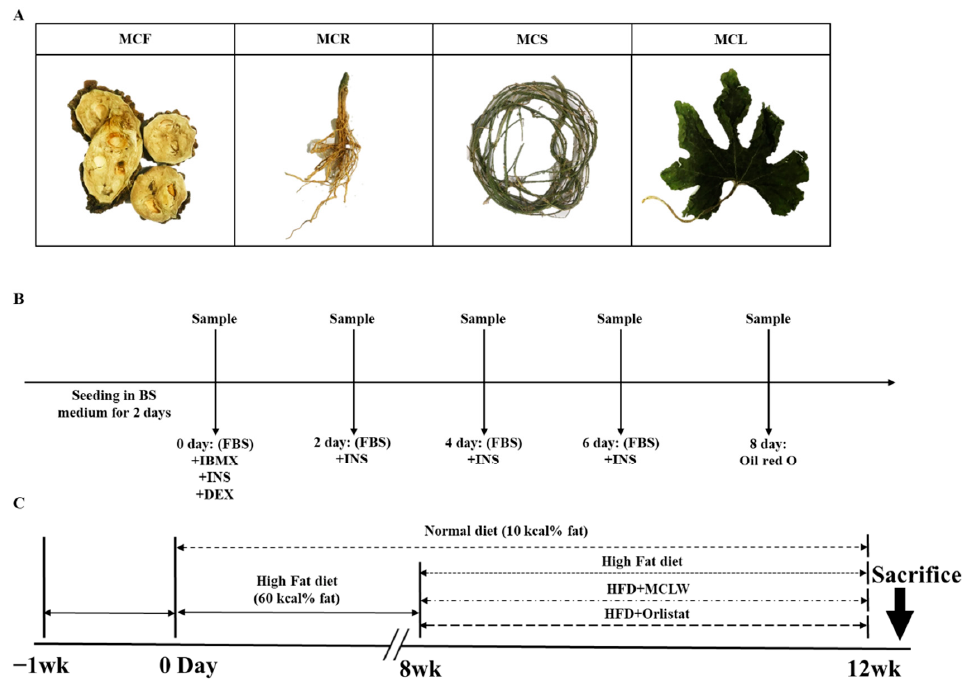
Figure 1. Background experimental information. Four parts of M. charantia used in antioxidant experiments, viz., fruit (MCF), root (MCR), shoot (MCS), and leaf (MCL) ( A ). Design of 3T3-L1 cell differentiation experiments ( B ). Timeline for the in vivo study ( C ). BS: bovine serum; FBS: heat-inactivated fetal bovine serum; IBMX: 3-Isobutyl-1-methylxanthine; INS: insulin; DEX: Dexamethasone; HFD: High fat diet.